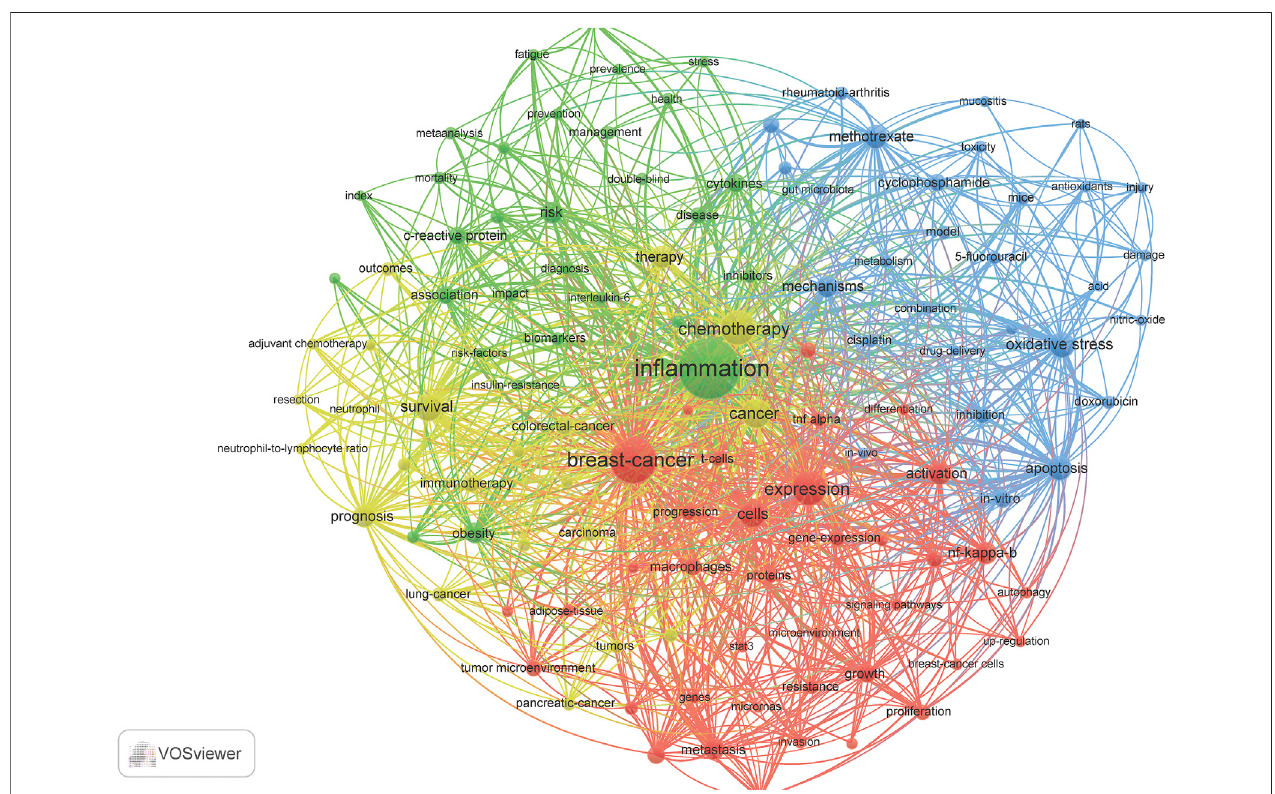
FIGURE 6 | Term map shows a visualization of 118 terms that occurred at least 20 times in the most current document from 2020 to mid-2021. Refer to Supplementary Table S5 for complete list of terms.